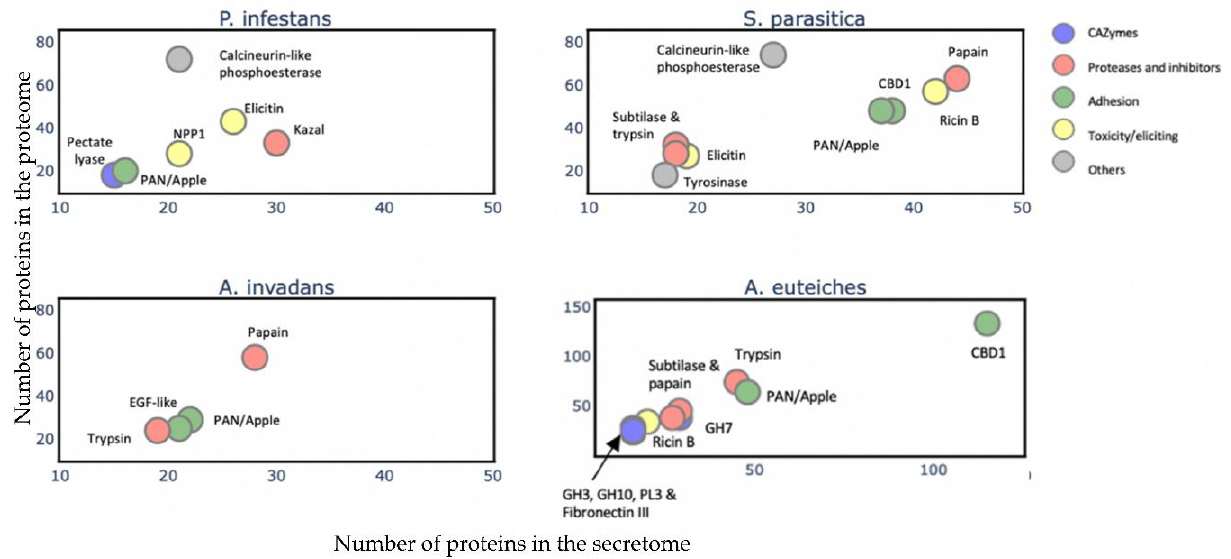
Figure 6. Comparison of A. euteiches secretome content with three other oomycetes. PFAM domains were searched in secreted proteins of two plant pathogens Phytophthora infestans (Peronosporale) and Aphanomyces euteiches (Saprolegniale) and two fish pathogens Saprolegnia parasitica and Aphanomyces invadans (Saprolegniale). Five classes of PFAM-containing proteins were identified. A PFAM domain present in more than 15 secreted proteins per class is represented as a colored circle and its name indicated above the circle. Arrow indicates overlaying circles. All selected PFAM domains were significantly enriched (Fisher’s exact test, p<0,05) with an enrichment coefficient (predicted secreted vs. expected secreted) over five for each class.